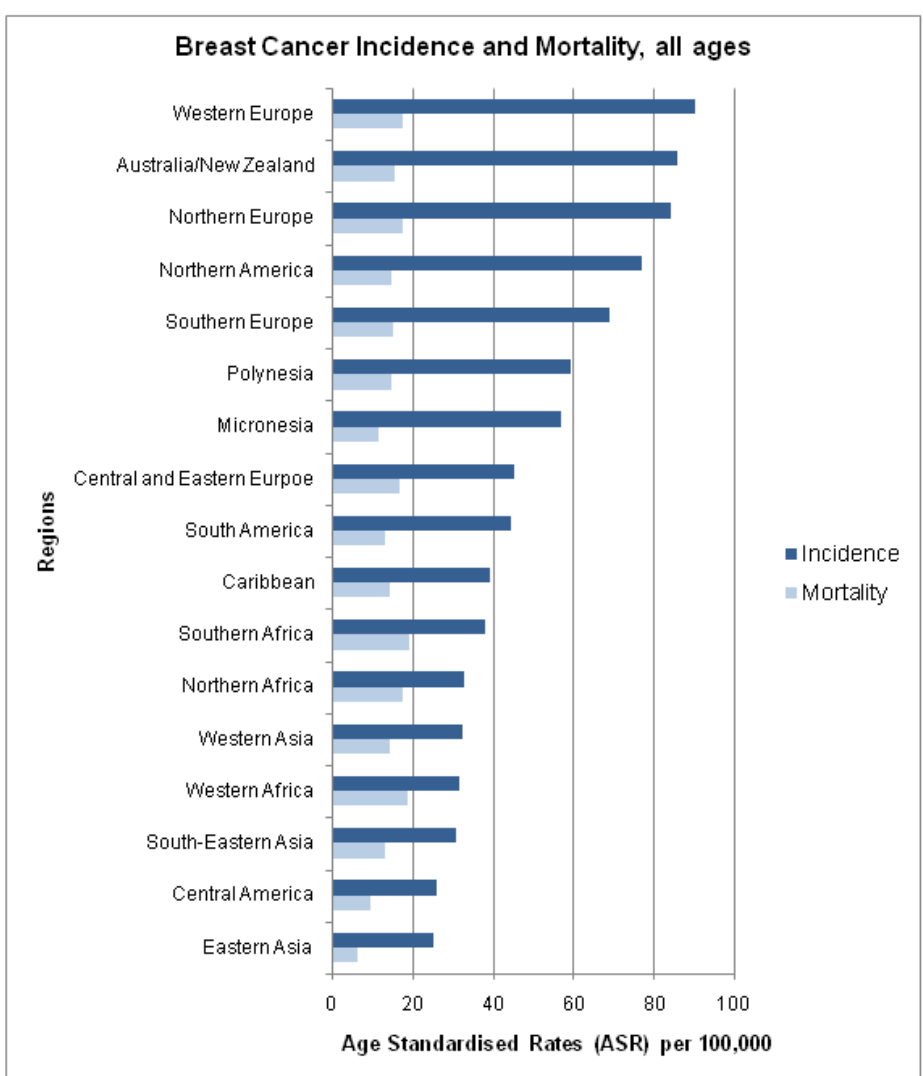
Figure 2. Estimated incidence and mortality from breast cancer in